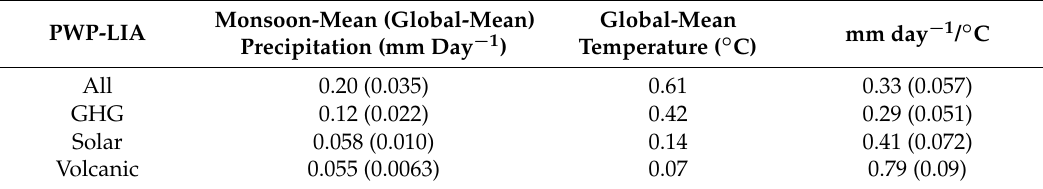
Table 1. Simulated differences of monsoon-mean(global-mean) precipitation and global-mean temperature between PWP and LIA, and monsoon-mean(global-mean) precipitation rate versus global-mean